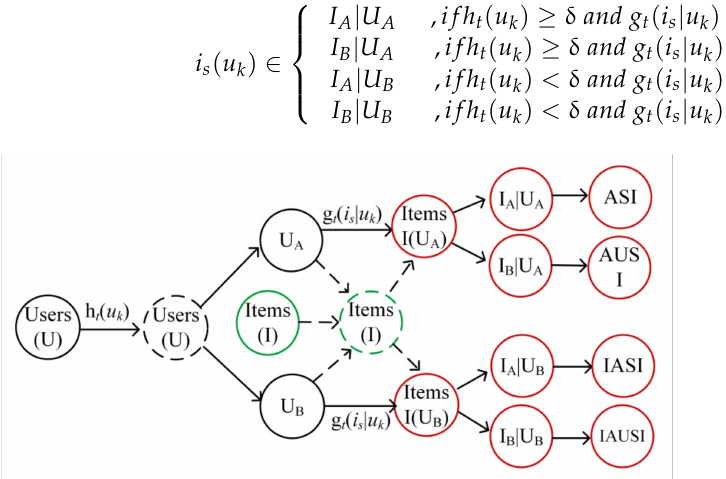
Figure 2. The classification structure of user–item